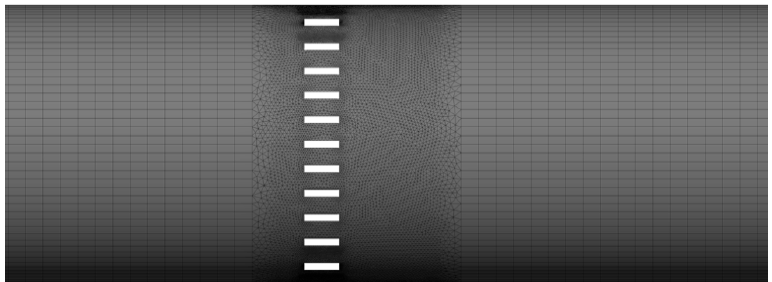
Figure 5. Block-structured grid for first version.